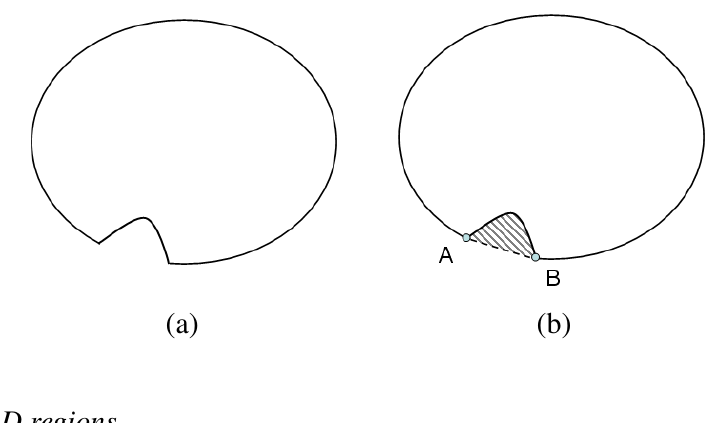
Figure 7. Schematic illustration of a 2D slice (a) for detection of critical points A and B, as well as the candidate region (rendered with gray stripes) shown in